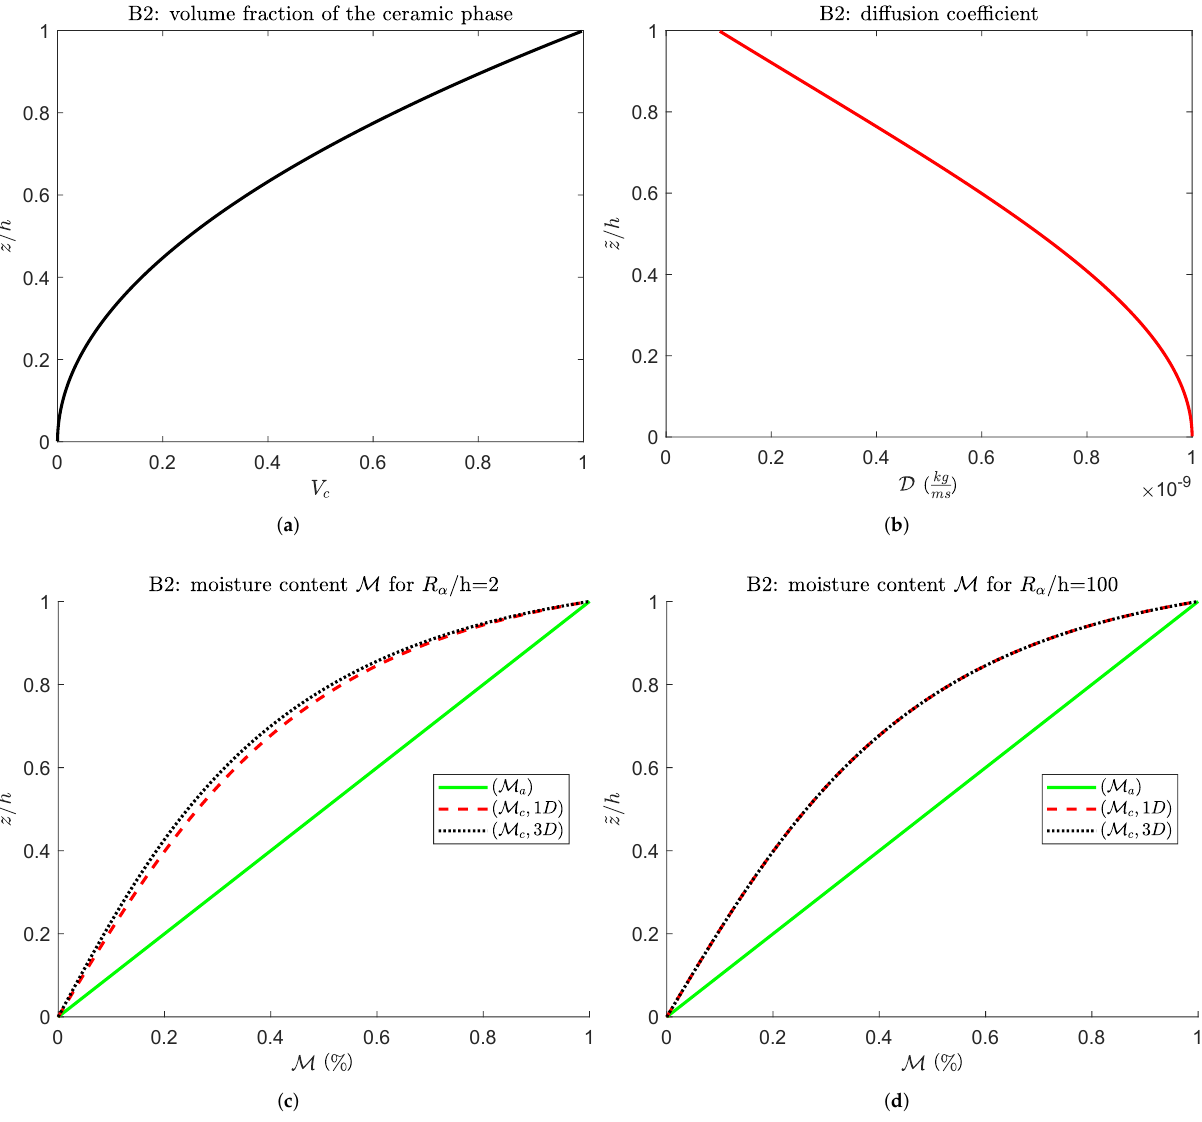
Figure 5. Second benchmark: one-layered FGM ( p = 2) cylinder with an imposed moisture content on the top and bottom surfaces. The figures show the volume fraction of the ceramic phase, the diffusion coefficient, and the moisture content profiles for a thick and a thin structure through their thickness. ( a ) Volume fraction of the ceramic phase V c . ( b ) Diffusion coefficient D . ( c ) Moisture content profile of the R α / h = 2 cylinder. ( d ) Moisture content profile of the R α / h = 100